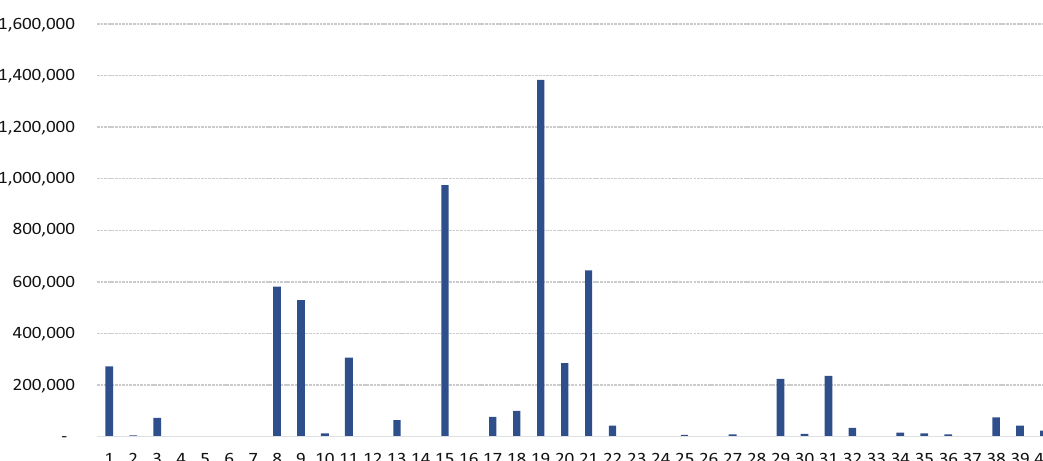
Figure 2: Plastic demand of 40 sectors in 2018. Note: ID and name of 40 sectors are presented in Table